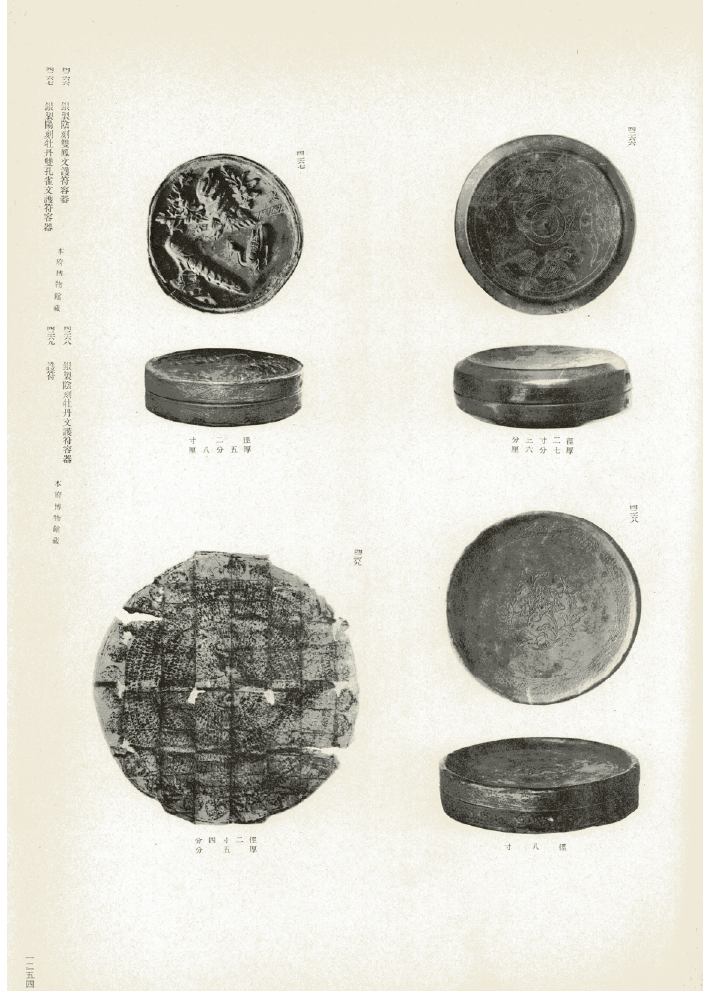
Figure 10. Metal cases and the Mah ā pratisar ā Dh ā ra ṇ ī print introduced in vol. 9, entitled “Craft- works Discovered inside Tombs of the Kory ŏ Period,” of the Album of Korean Antiquities ( Ch ō sen Discovered inside Tombs of the Koryŏ Period,” of the Album of Korean Antiquities ( Chōsen koseki zufu koseki zufu 朝鮮古蹟圖譜 ). After (Ch ō sen s ō tokufu 1929, p. 1254). 朝鮮古蹟圖譜 ). After (Chōsen sōtokufu 1929, p.